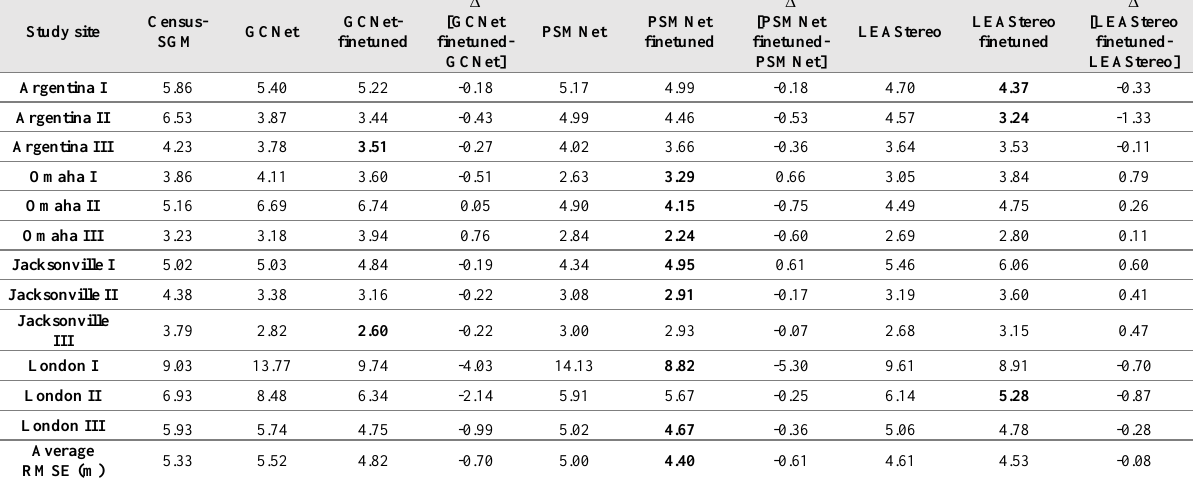
Table I. Numerical evaluation for the RMSE (meters) of DSMs generated using different DL algorithms for all study sites. Note: the ∆ refers to the difference between the RMSE for DL algorithms before and after finetuning